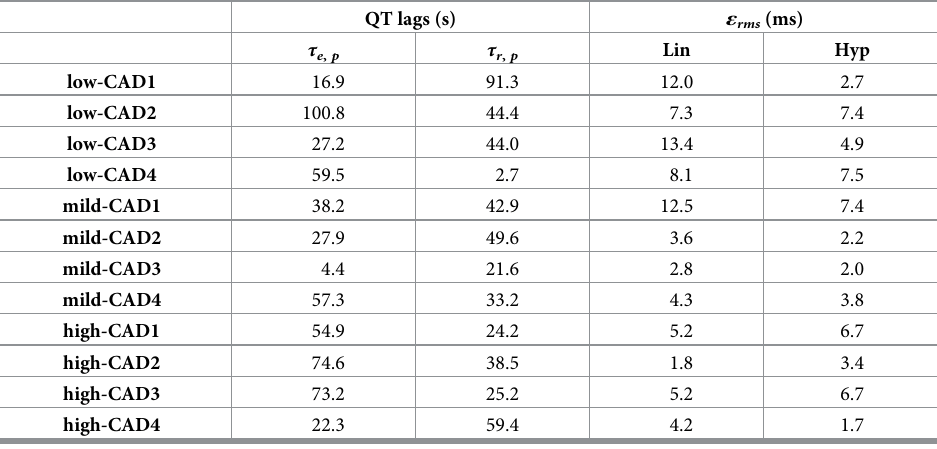
Table 1. Left column: codes used to identify the analyzed patients according to the risk group and the patient order number # within the group. Middle column: QT adaptation delay values measured in the exercise and recovery phases of the stress test for each patient, denoted by τ and τ with p indicating estimated from patients’ data. Right column: e , p r , p mean square error ε rms for the linear and hyperbolic regression models calculated using the U